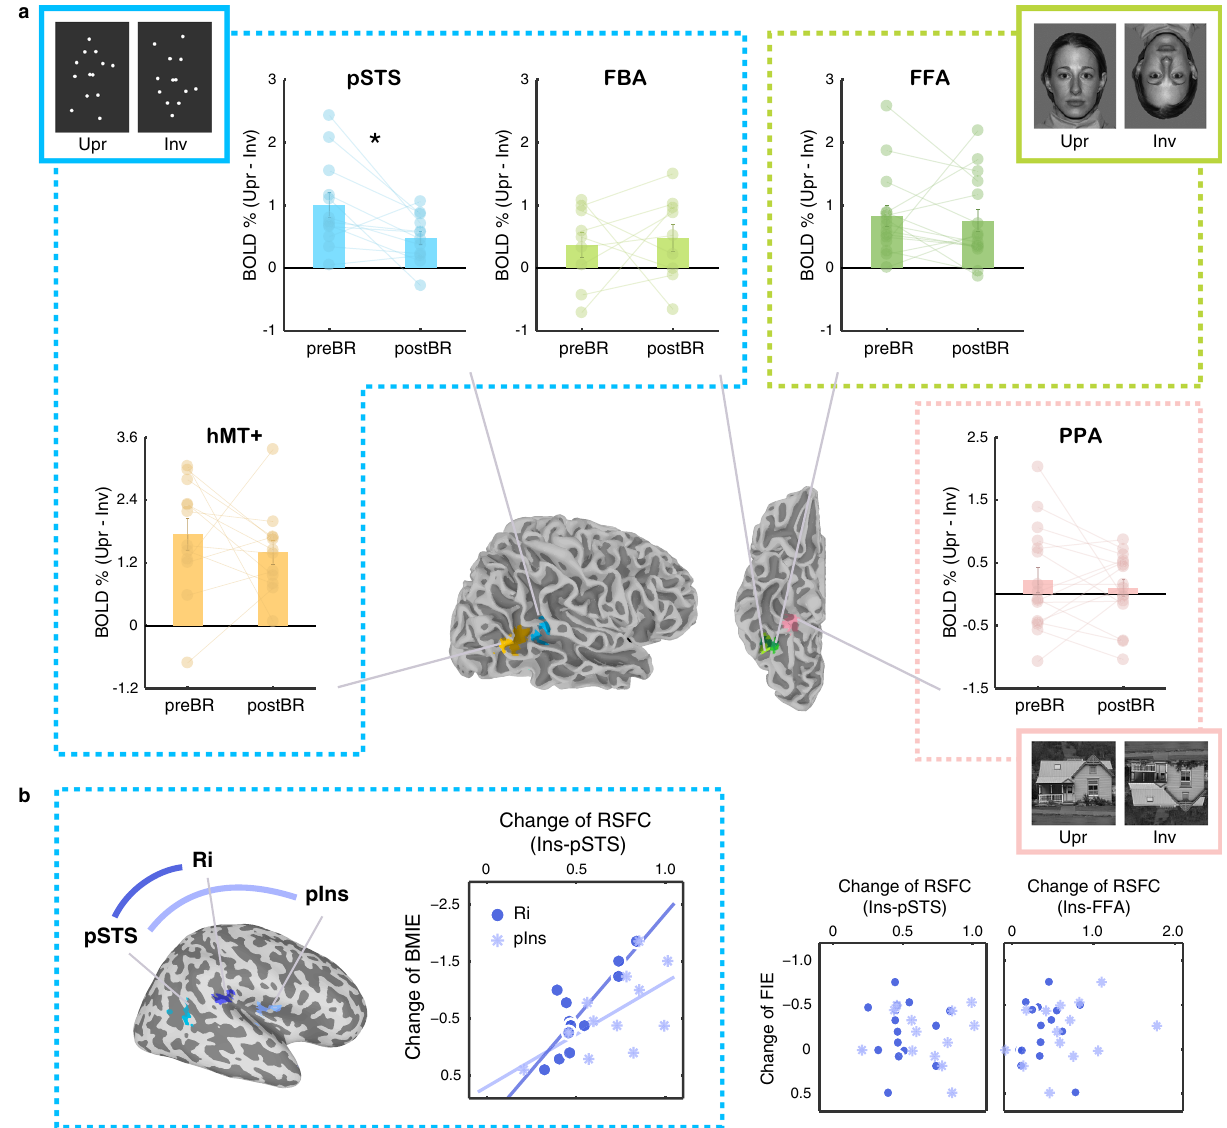
Fig. 4 Results of ROI analysis based on the fMRI data obtained before and after the HDTBR. a The bar charts show the BM inversion effect in the pSTS, hMT + , and FBA, the face inversion effect in the FFA, and the house inversion effect in the PPA, averaged across participants. Colored dots represent individual data. Error bars indicate ±1 SEM. *: p = 0.019 (two-tailed paired t-test). A summary of the ROIs is displayed in a single participant. b The enhancements of resting-state functional connectivity (RSFC) between the pSTS and two insula ROIs (Ri: retroinsula; pIns: posterior insula) after vs. before the bed rest were signi fi cantly correlated with the change of the inversion effect in BM perception (BMIE). No reliable correlation was observed between such RSFC change and the change of the inversion effect in face perception (FIE), or between the Ins-FFA RSFC change and the change of perceptual FIE. Note that in a and b, we present data obtained from participants who showed valid performances in the corresponding behavioral task to facilitate the further correlation analysis (see methods for details; n = 12 in the BM condition for pSTS and MT + , n = 9 for FBA since no cluster could be identi fi ed in three participants due to noisy signals; n = 15 in the face condition for FFA, and n = 16 in the house condition for PPA). Additional results for ROI analysis based on data from all participants ( n = 16) are shown in Fig. S1. Source data are provided as a Source Data fi Ri: r = − 0.84, p < 0.001; pIns: r = − 0.61, p = 0.034), suggesting a key functional role of the insula-pSTS connectivity in the observed change of the gravity bias in BM perception. By contrast, there were no signi fi cant correlations between the enhancement of the pSTS-Insula connectivity and the change of the perceptual face inversion effect (Fig. 4b; Ri: r = − 0.01, p = 0.972; pIns: r = 0.05, p = 0.878) and between the change of the face inversion effect and that of the FFA-Insula connectivity (Fig. 4b; Ri: r = − 0.06, p = 0.825; pIns: r = − 0.29, p = 0.322). Taken together, these results convergently suggest that the altered functional connectivity between cortical regions dedicated to